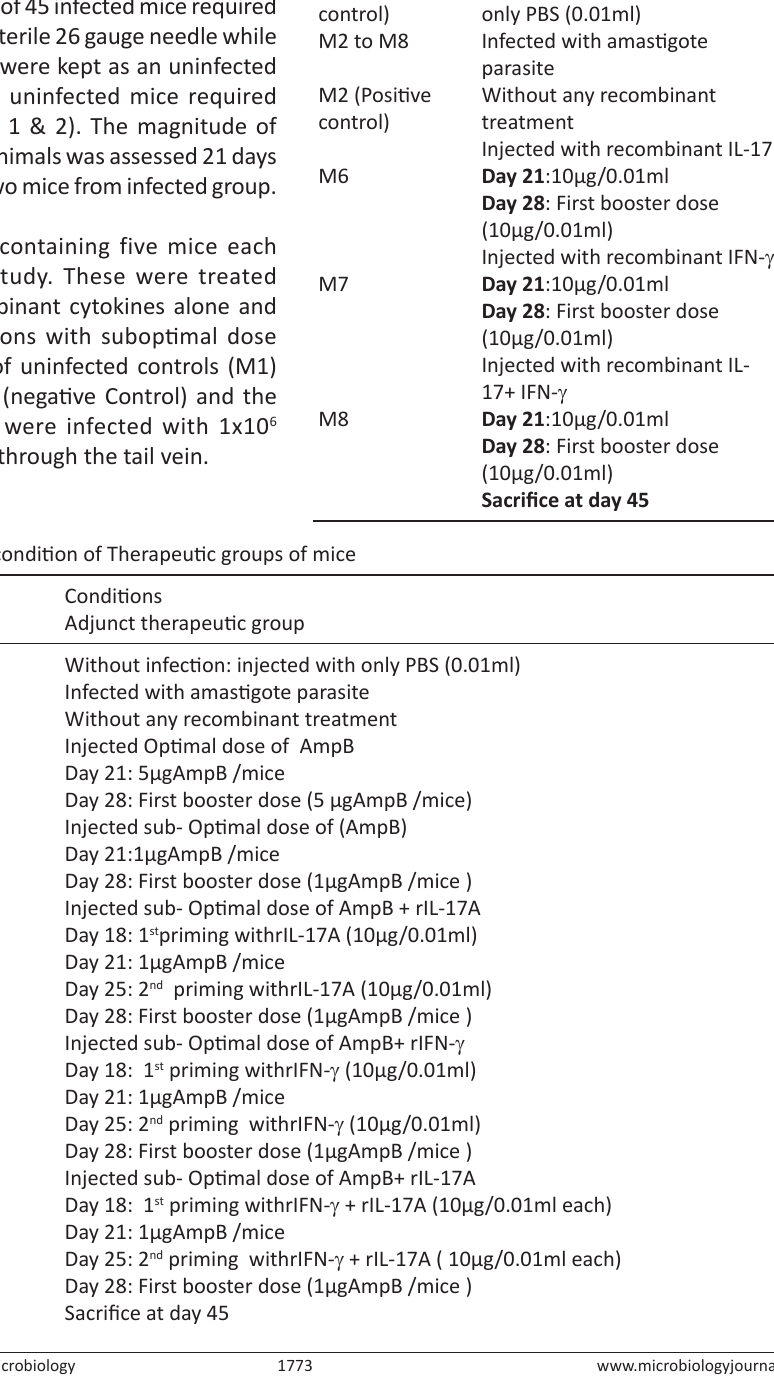
Table 1. Experimental condition of Therapeutic groups of mice Group of Mice